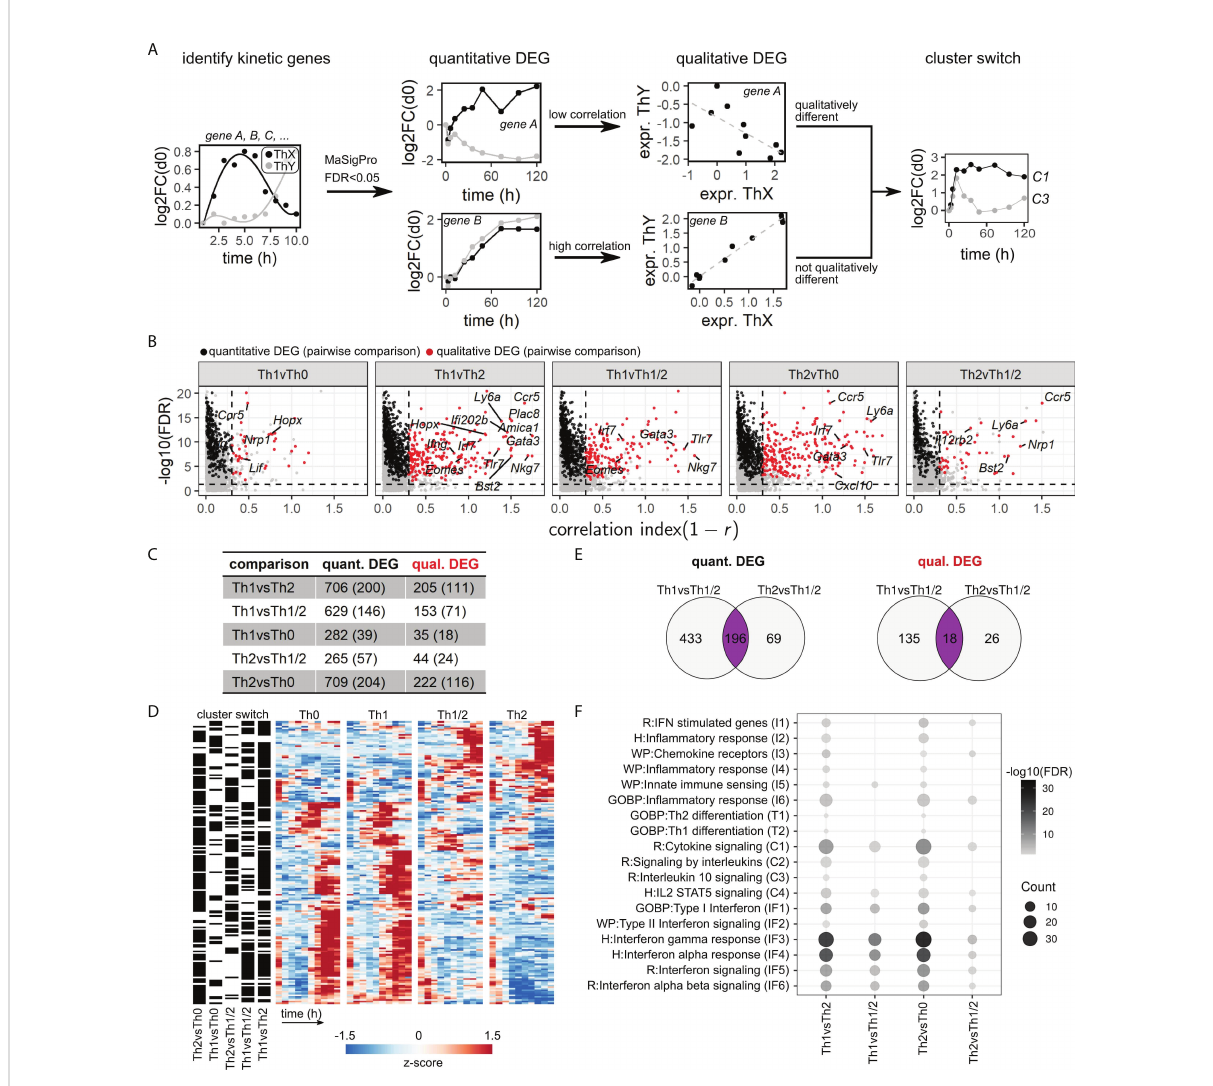
FIGURE 3 A re fi ned selection procedure identi fi es quantitative and qualitative differences in kinetic gene expression. (A) Work fl ow illustration. We employed a combination of regression fi tting in maSigPro to derive quantitative differentially expressed genes (DEG), followed by a correlation fi lter to identify qualitative DEG and by an analysis of switching of kinetic clusters between cell types. (B) Correlation volcano plots based on the work fl ow in (A) . Genes are categorized as kinetic (gray), quantitative DEG (black), or qualitative DEG (red). See Methods for details. (C) Numbers of qualitative and quantitative DEG obtained for each comparison of cell types. Brackets indicate the numbers of kinetic cluster switches. (D) Expression heatmap for all qualitative DEG exhibiting kinetic cluster switches in at least one comparison of cell types, as indicated on the left. (E) Venn diagrams of quantitative (left) and qualitative (right) DEG shared between Th1 or Th2 cells and Th1/2 hybrid cells. (F) Pathway enrichment analysis of DEG for all pairwise comparisons between cell types. Pathways were pooled from REACTOME, GO:BP, Msigdb:C2: WikiPathways, and Msigdb:C3:TFT databases. Shown are pathways with signi fi cant enrichment in at least two